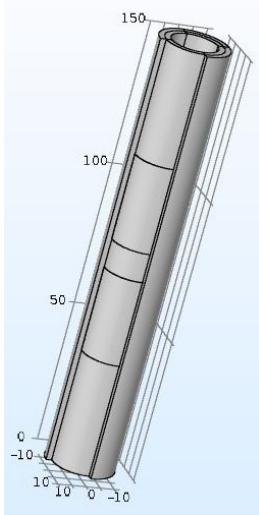
Figure 4. Cylindrical sensor shape.